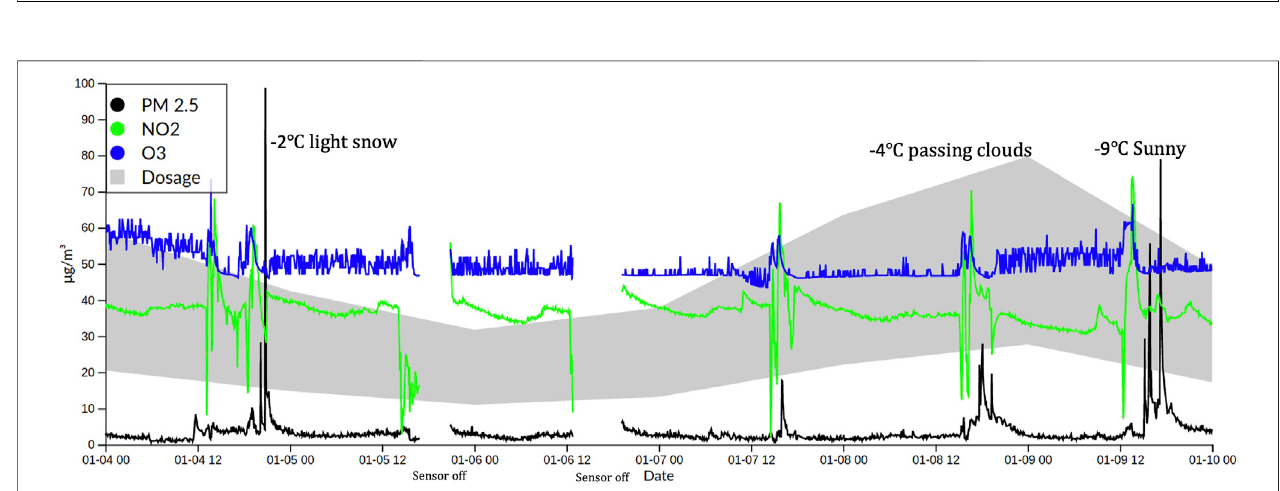
FIGURE 7 | Hourly PM 2.5 , NO 2. O 2.5 concentrations measured by HOPE sensor unitincluding of fl ine periods (January 04, 2021 – 10.01.2021). The grey envelope represents hourly inhaled dosage rate proxy. The top line of the grey area based on male breathing rate the bottom line based on female breathing